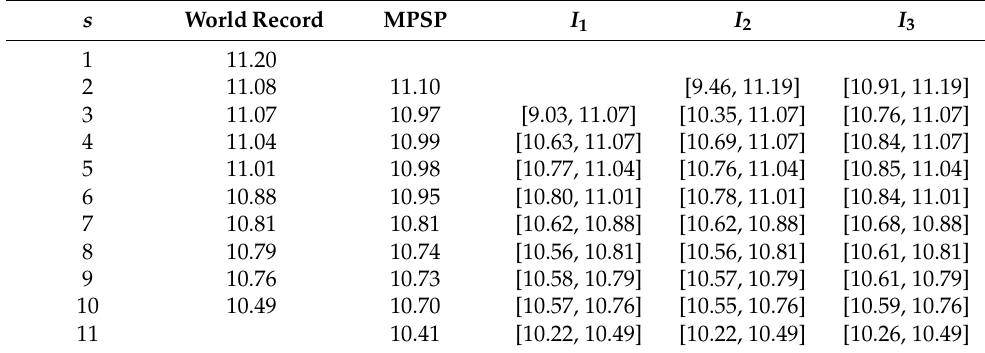
Table 3. World records, maximum product of spacings predictor and (approximate) 90% prediction intervals I 1 , I 2 and I 3 for the next record of the women’s 100 m based on the previous records.